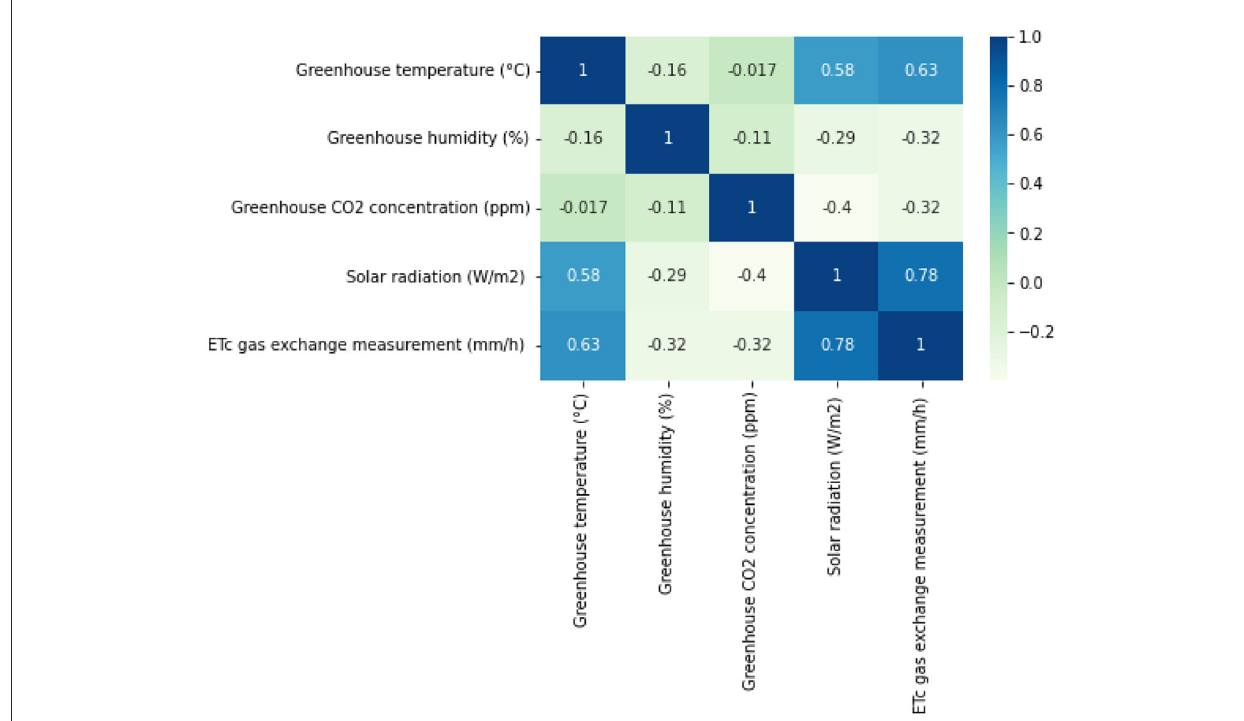
FIGURE3 Correlation matrix between different microclimate variables and transpiration.